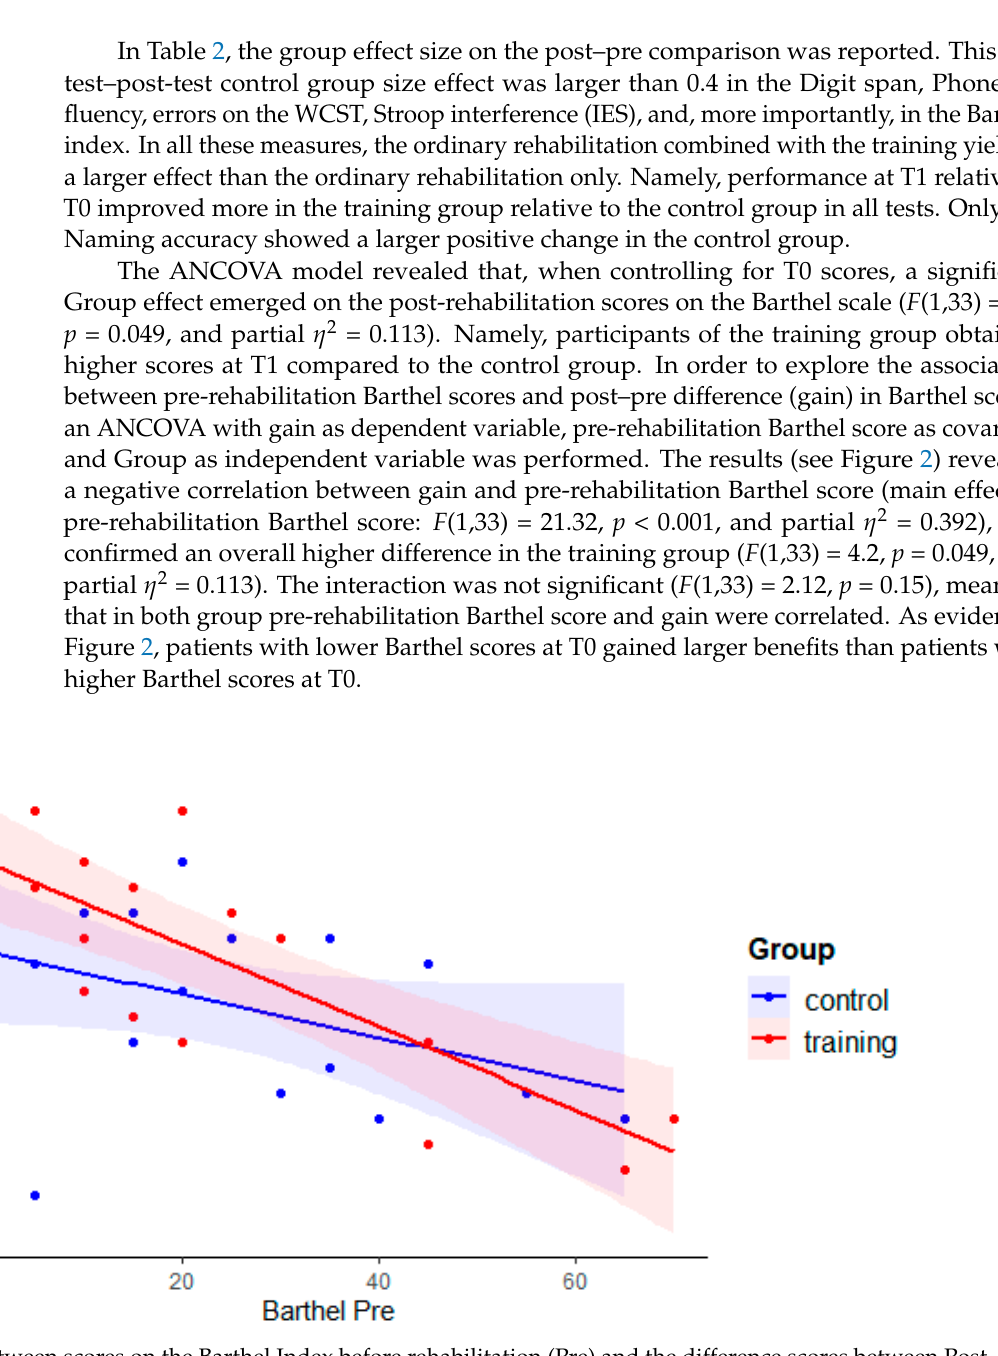
Figure 2. Relation between scores on the Barthel Index before rehabilitation (Pre) and the difference scores between Post- and Pre-rehabilitation, in the training and control groups.